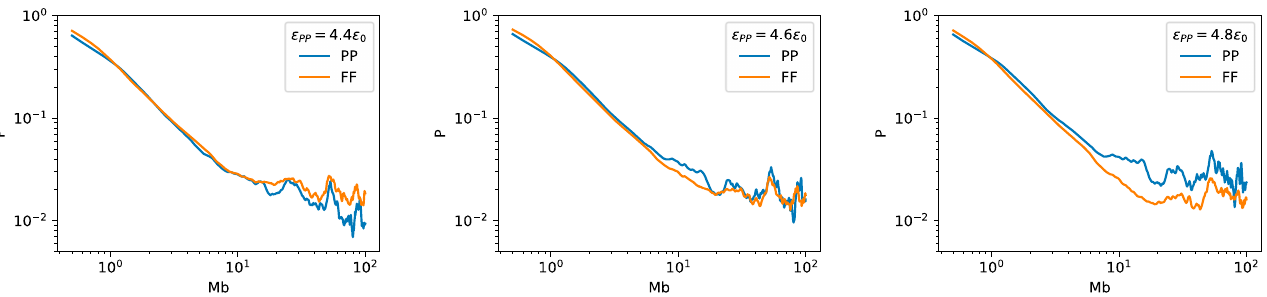
Figure A2. FF and PP contact probability ( P ) as a function of sequential distance obtained from the 1-Chr system considering different ε FF values.